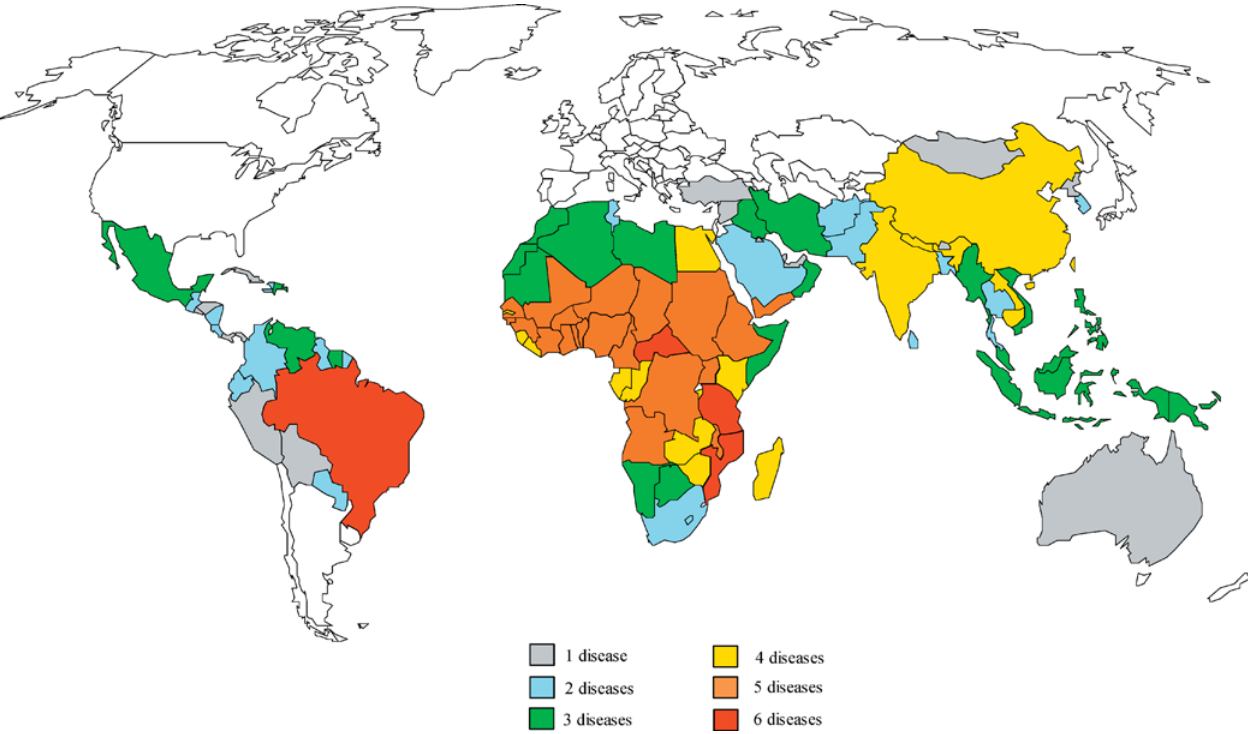
Figure 1. Geographic Overlap of the Neglected Tropical Diseases (Figure: Molly Brady, Emory